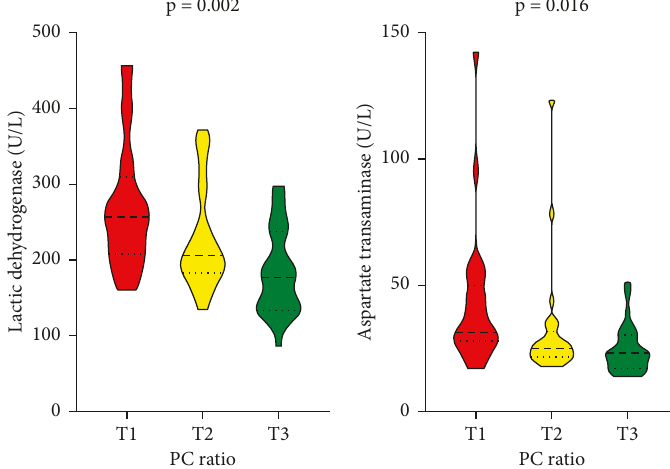
Figure 3: Comparison of multi-organ injuries in PC